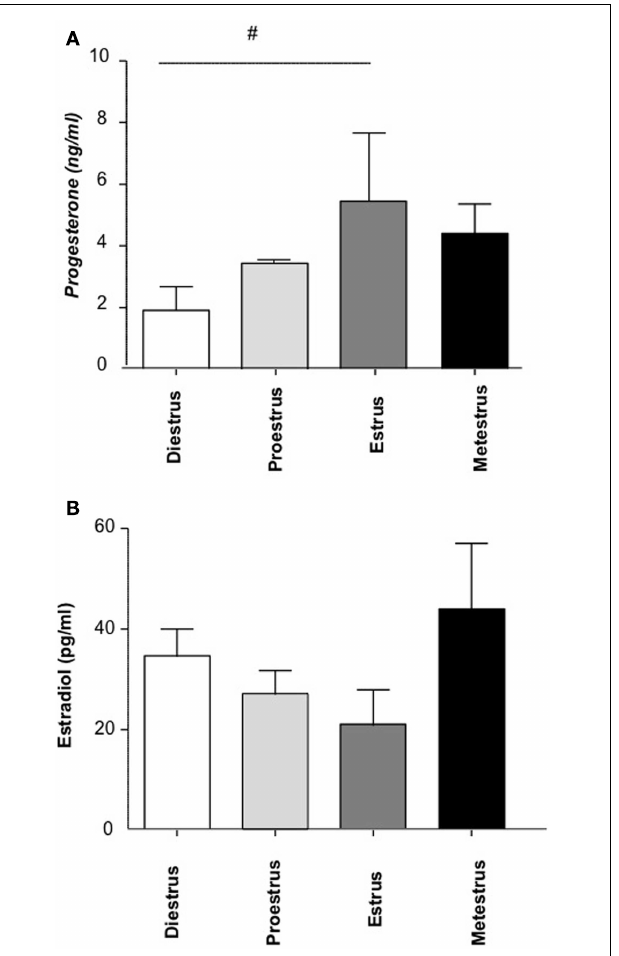
FIGURE 2 |The concentration of progesterone (A) and estradiol (B) during the estrous cycle ( n = 16, 4/cycle) . Progesterone and estradiol levels in plasma were analyzed by ELISA following the instructions of the manufacturer. n = 4 mice/phase were included and the statistic analysis was performed by two-way ANOVA. # p <